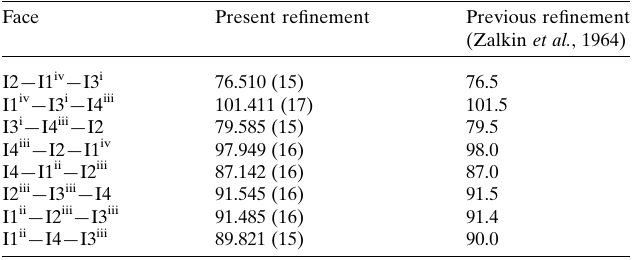
Table 1 The I—I—I angles ( (cid:2) ) within the irregular ThI 8 coordination polyhedron. Face Present